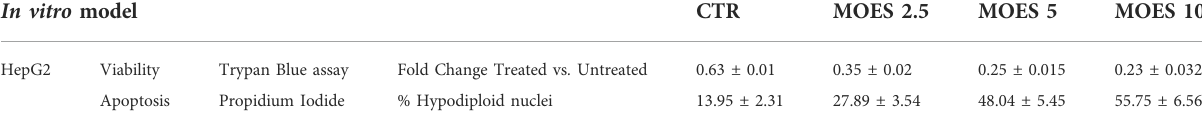
TABLE 1 Effect of MOES on HepG2